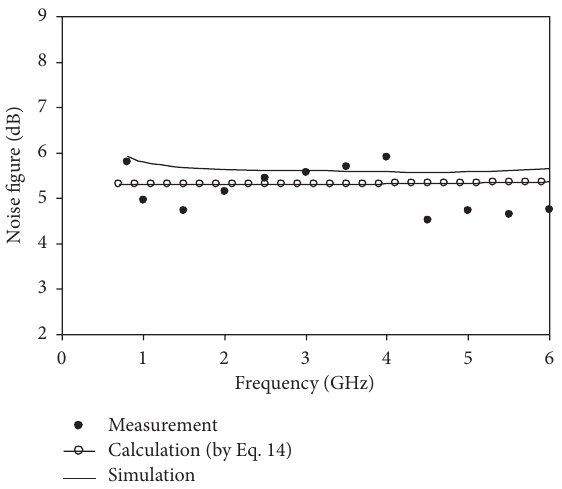
Figure 8: IIP3 of the proposed receiver front-end.